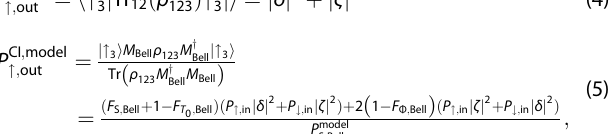
Fig. 4 Correlation between the spin-up probabilities of the output qubit, P CI " ; and P CI ; model " ; . Horizontal error bars represent out out the SE. Vertical error bars represent error calculated using Eq. (5) . P CI " ; is the one observed experimentally, with the SE of P CI " ; out out is what is expected from the model. The red line whereas P CI ; model " ; out and P CI ; model " ; are identical. P CI " ; is shows the ideal case when P CI " ; out out out obtained by averaging the scattered data points at each t burst in Fig. 3a for clarity. P CI ; model " ; is calculated by assuming no errors in the out whole process of the QT protocol (pink triangles), fi nite errors in preparation and detection of singlet (orange squares), and an additional mapping error in the input qubit readout (blue circles), ¼ 0 : 38 , respectively. We use estimated values of F S ; Bell (cid:2) F T 0 ; Bell F Φ ; ¼ 0 : 96 , δ j j 2 ¼ 0 : 51 , and ζ j j 2 ¼ 0 : 05 (for orange squares and Bell blue circles), and f in ; " ( f in ; # ) ¼ 0 : 90 ( 0 : 93 ) (for blue where 1 (cid:2) F S ; Bell , 1 (cid:2) F T , and 1 (cid:2) F Φ ; Bell are the detection errors 0 ; Bell of the singlet S , the non-polarized triplet T 0 , and the other two Bell states Φ ± .